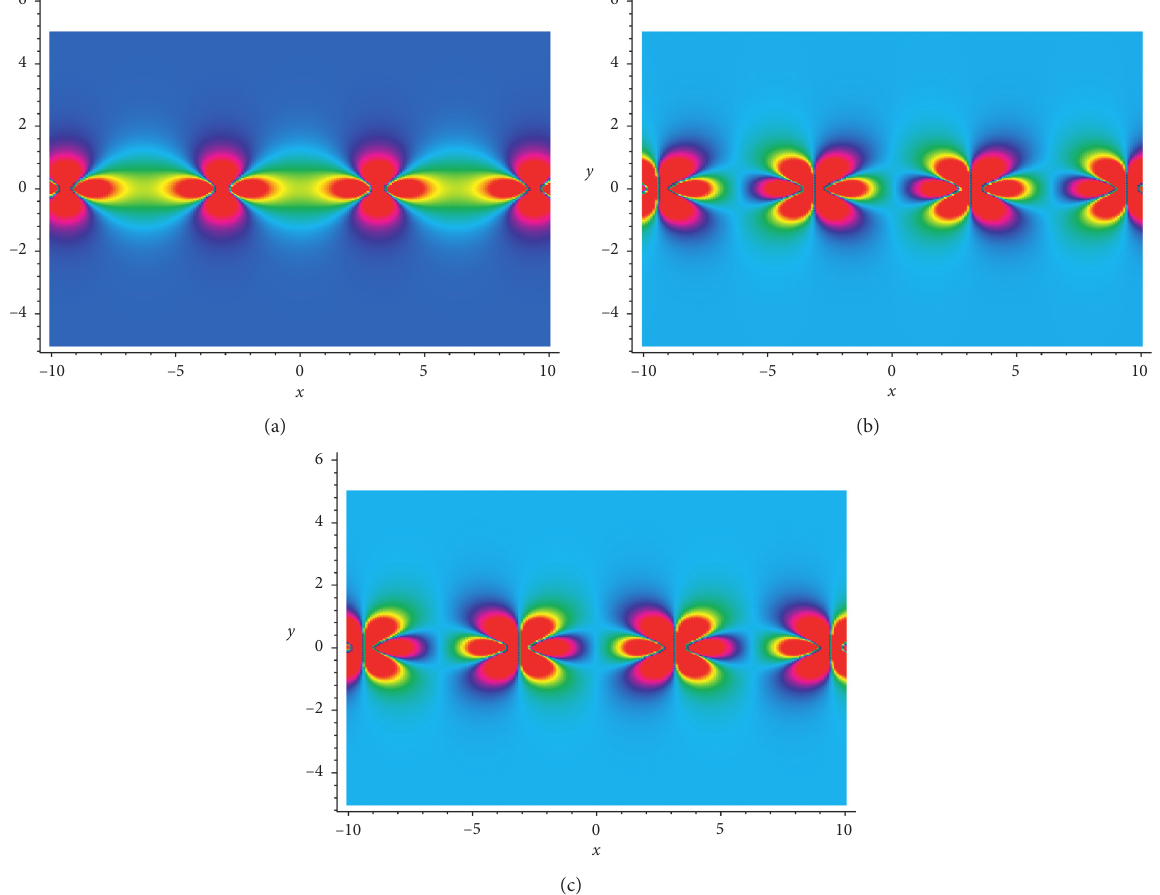
Figure 4: The density plot of the x -periodic symmetry breaking breather of the AB-KP systems (7a) and (7b), with the selected parameters b � b � 0 and (b) and (c) b and b are (a) b 2 1 2